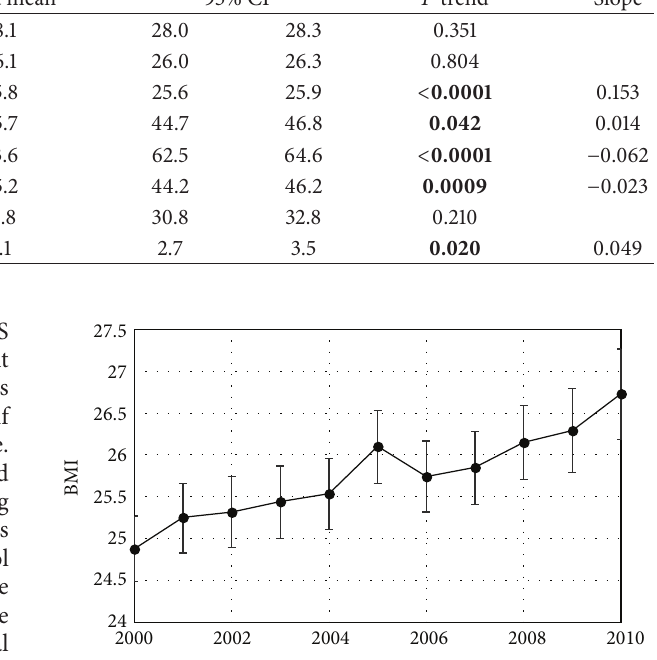
Figure 1: Maternal prepregnancy BMI ± 95% CI of women giving birthinMaineshownbyyear.MeanBMIincreasedatanaveragerate of 0.15 BMI units/year. Healthy People 2020 objectives include a 10% increase in the proportion of women who had a healthy weight prior topregnancy.GiventhatBMI > 25iscurrentlydefinedasoverweight while BMI > 30 is currently defined as obese, Maine is not moving toward this